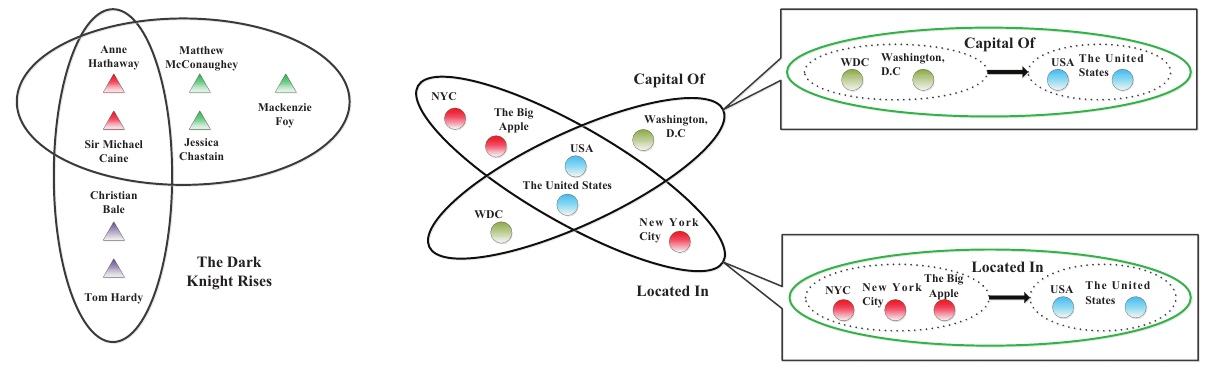
Figure 1. Sketch of two types of hypergraphs. The diagram on the left represents an undirected hypergraph while the diagram on the right stands for a directed hypergraph. One ellipse denotes a hyperlink. entities in the same ellipse share the same hyperlink. Arrow denotes the direction of the